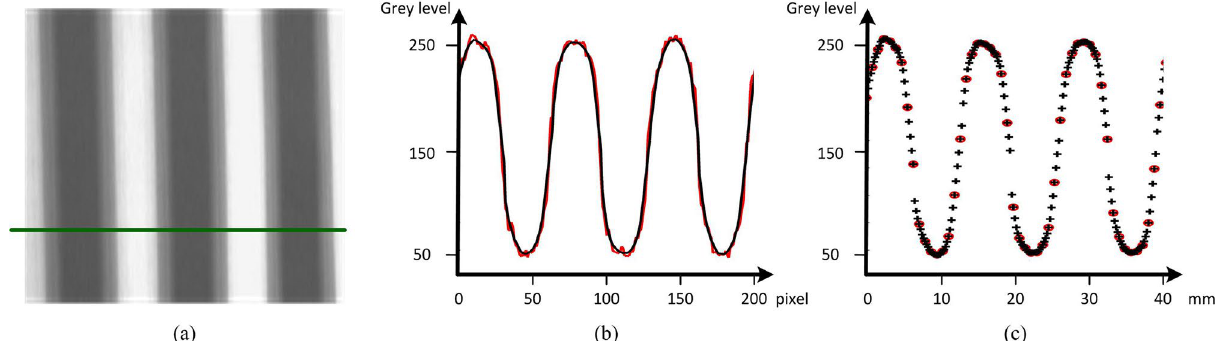
Figure 4. Comparative results. ( a ) The reconstructed stripe image. ( b ) Intensity distributions of the projected sinusoidal stripe in the reconstructed image of DMD camera and the image of traditional camera with N times resolution. ( c ) Spatial sampling distribution of the projected sinusoidal stripe in the reconstructed image and the non-reconstructed